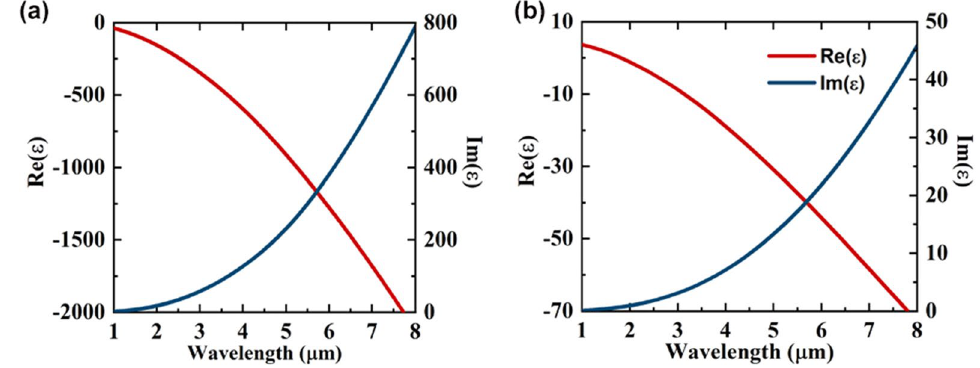
Fig. 1 Wavelength-dependent real and imaginary parts of the permittivity of Au a and nGaN ( n = 3.7 × 10 20 cm − 3 )